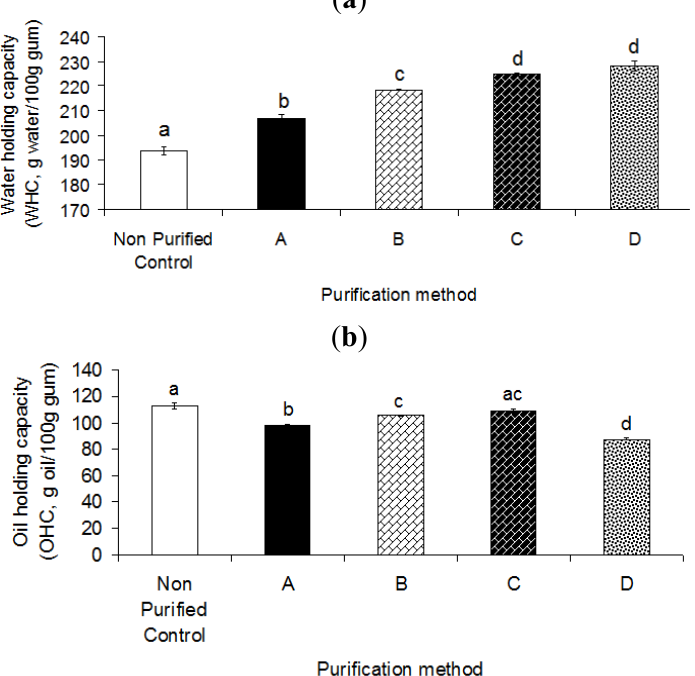
Figure 4. ( a ) Effect of different purification methods on the water-holding capacity (WHC). ( b ) oil-holding capacity (OHC) of heteropolysaccharide-protein biopolymer from durian seed. A, isopropanol and ethanol; B, isopropanol and acetone; C, saturated barium hydroxide; D, Fehling